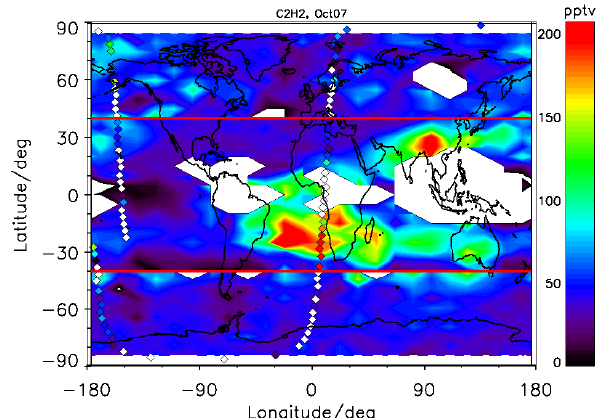
Fig. 13. As Fig. 10 but for C 2 H 2